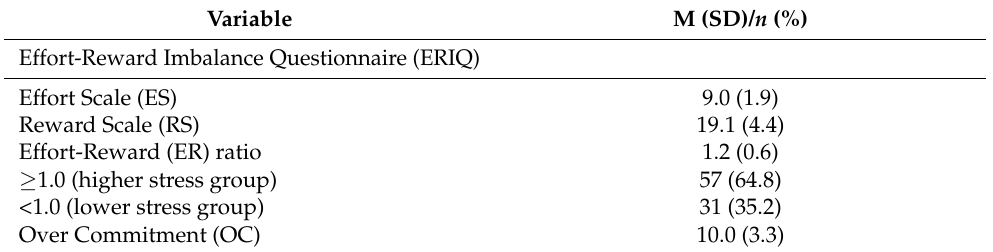
Table 2. Levels of work-related stress of Korean workers ( n = 95, valid case only).